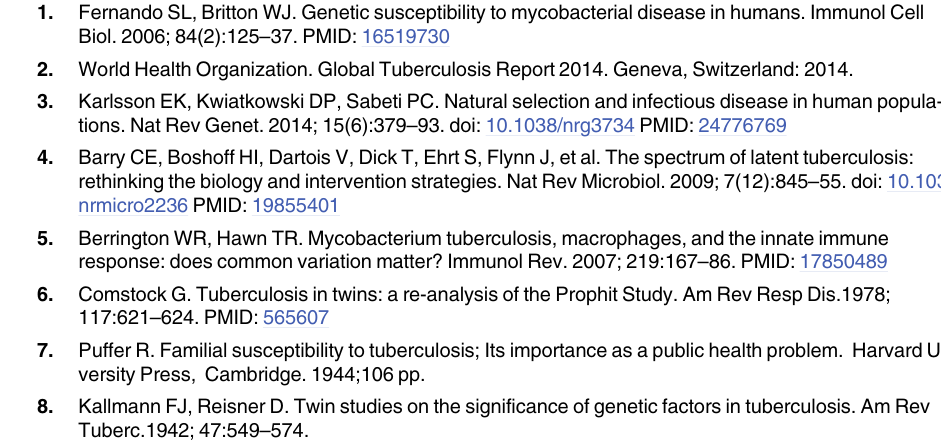
S4 Table. Allelic, Genotypic and Carrier Frequencies of Cytokine SNPs in